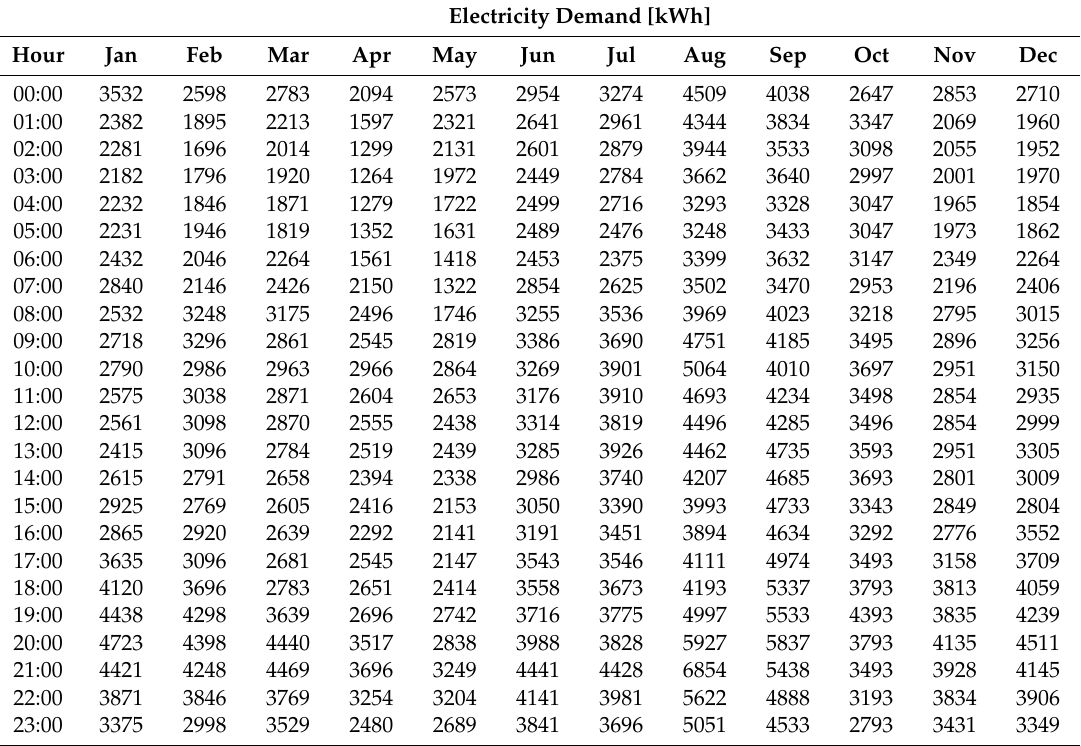
Table A2. Electricity demand in monthly standard days in Pantelleria [80].